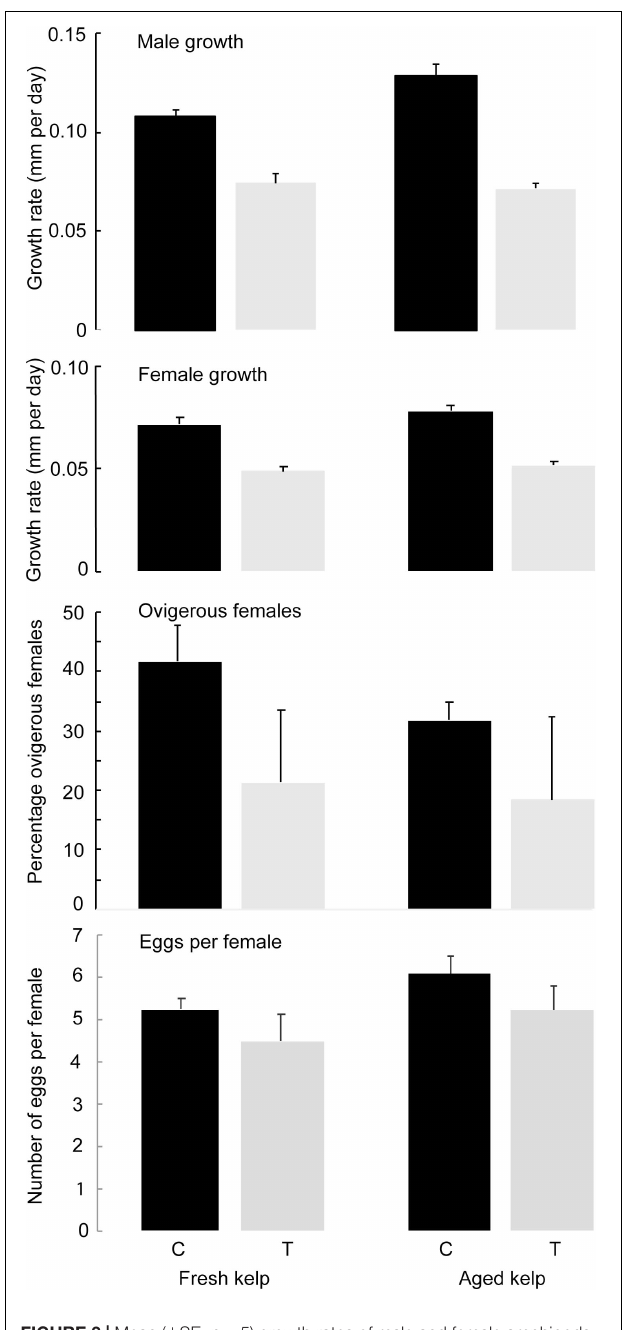
FIGURE 3 | Mean ( ± SE, n = 5) growth rates of male and female amphipods (mm/day), and percentage of ovigerous female and number of eggs per female amphipods in different wrack types (Fresh and 2 weeks Aged kelp) and treatment [Control (C) and Antibiotic treatment